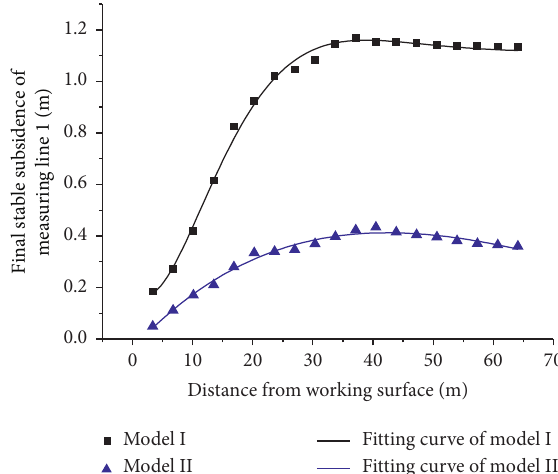
Figure 9: Experiment value and fitting curve of the final stable subsidence of measuring line 1 in two models.